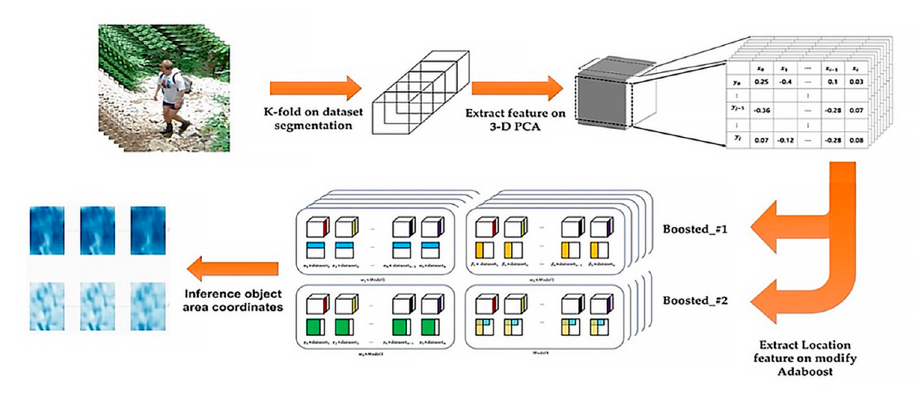
Figure 1. Proposed detection system on the Boosted 3-D PCA.